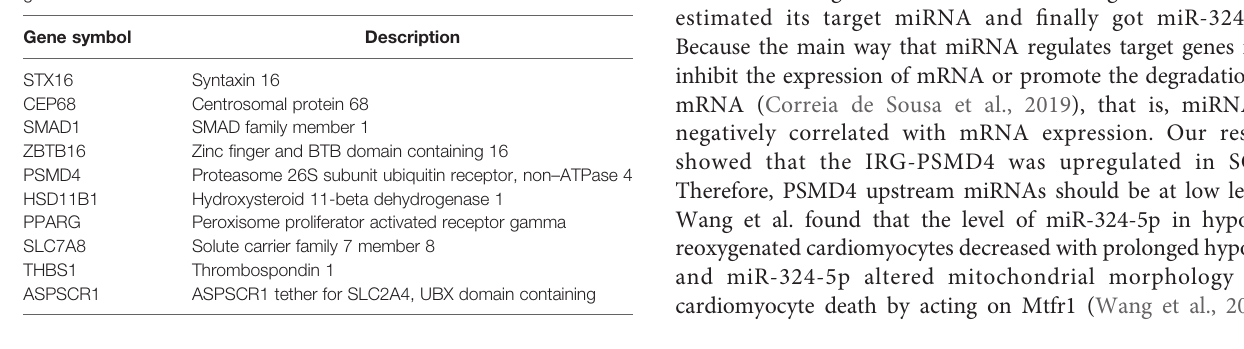
TABLE 3 | Top 10 genes that intersect with immune genes among differential